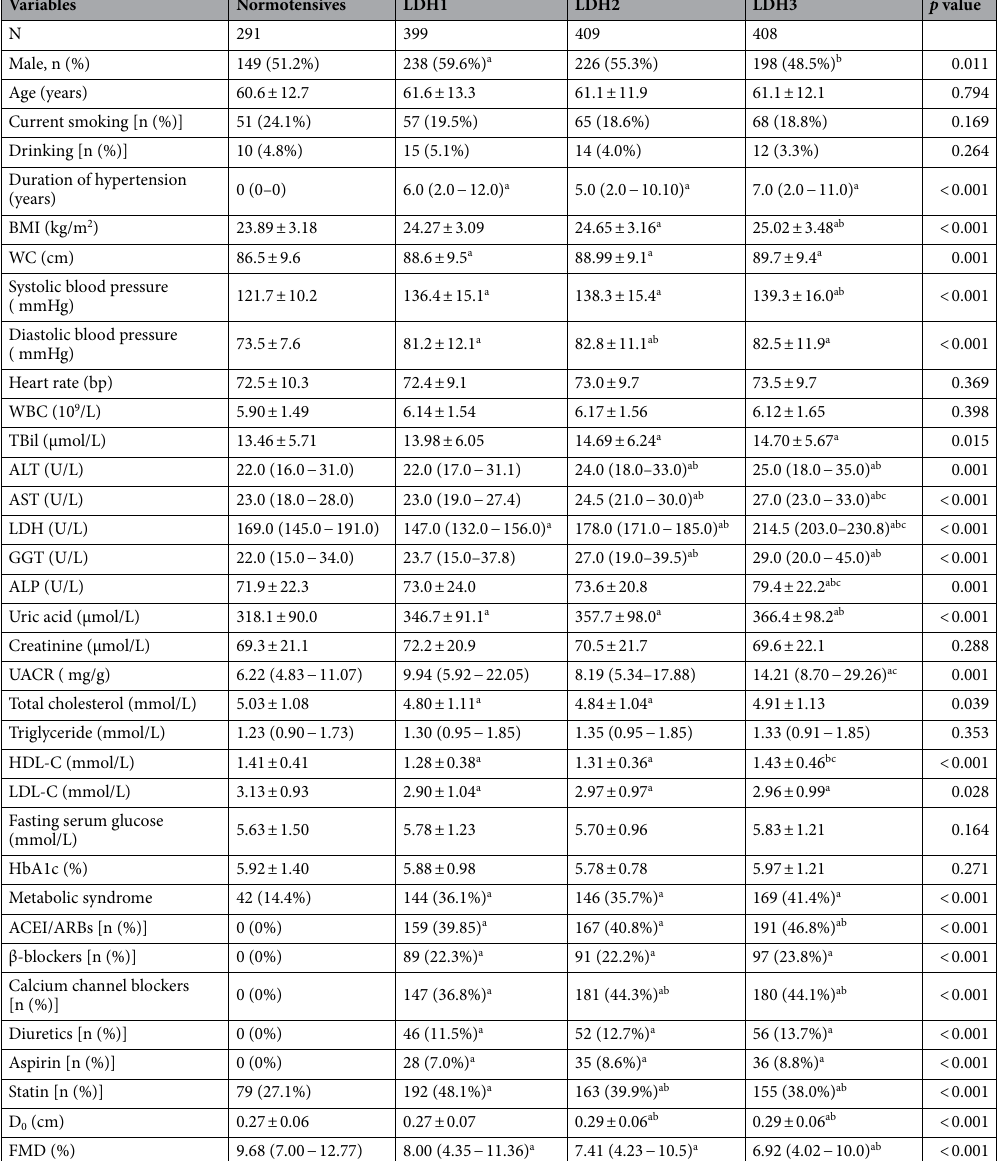
Table 1. Clinical characteristics of all subjects with and without hypertension. BMI body mass index; WC waist circumference; WBC white blood cell counts; TBil total bilirubin; ALT alanine aminotransferase; AST aspartate aminotransferase; LDH lactate dehydrogenase; GGT gamma glutamyl transpeptidase; ALP alkaline phosphatase; UACR urinary albumin to creatinine ratio; HDL-C high-density lipoprotein-cholesterol; LDL-C low-density lipoprotein-cholesterol; HbA1c glycosylated hemoglobin; ACEI Angiotensin-converting enzyme inhibitor; ARB angiotensin receptor blocker; D 0 baseline diameter of anterior tibial artery; FMD flow-mediated dilation. Data are expressed as means ± SD or median (25th–75th). a p < 0.05 versus normotensives, b p < 0.05 versus LDH1 group, c p < 0.05 versus LDH2